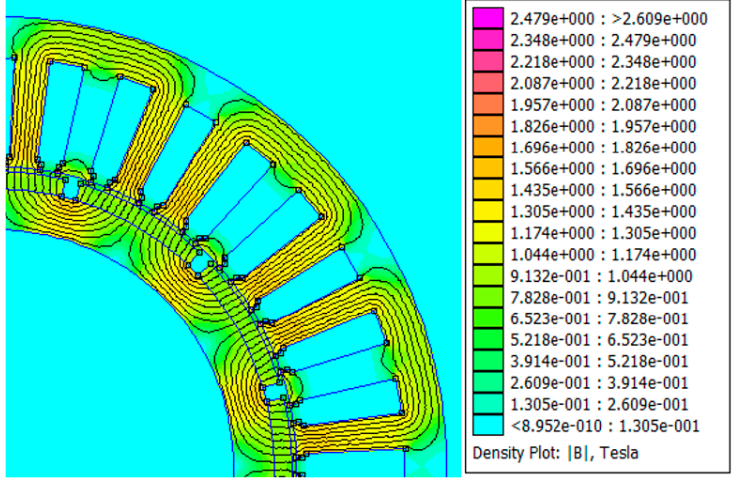
Figure 7. 2D magnetic flux density and vector potential in the permanent magnet synchronous generator.